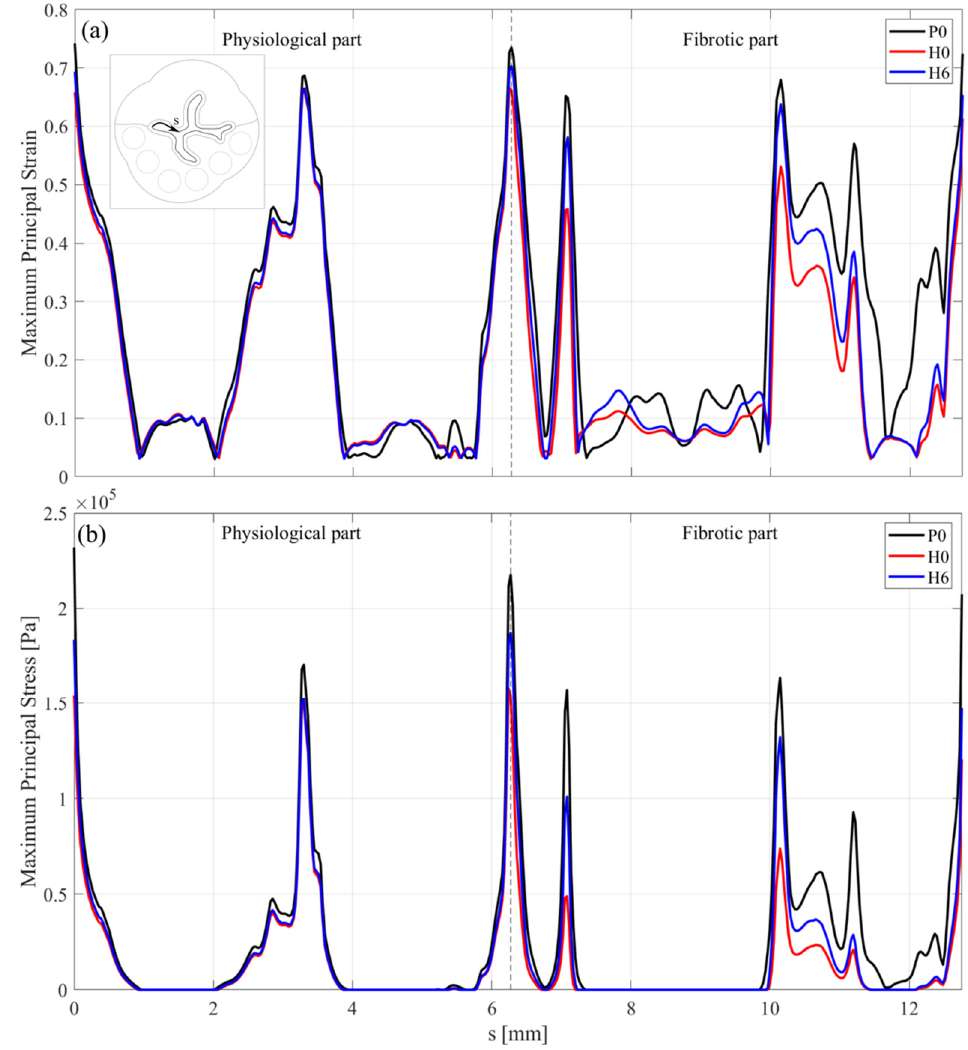
Figure 7. Maximum principal strain and stress along the intraluminal boundary for tests P0, H0, and H6: ( a ) physiological part; ( b ) fibrotic part.